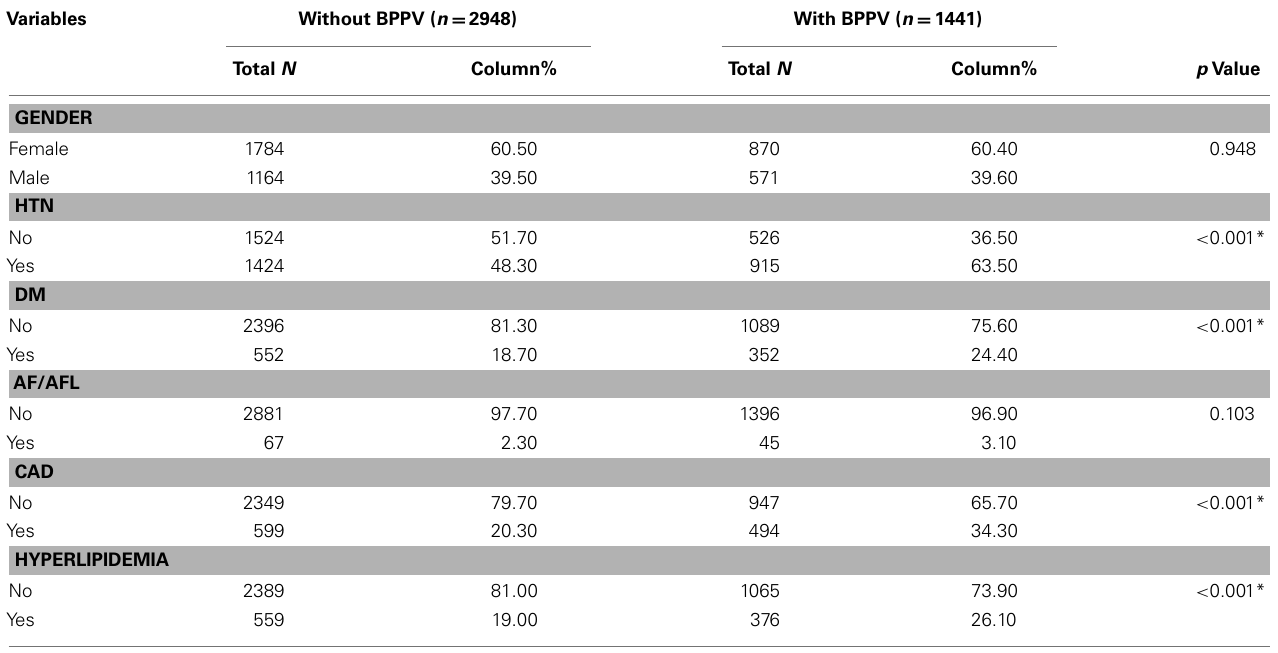
Table 3 | Clinical characteristics of individuals more than 65-year-old with and without BPPV ( n = 4389) . Variables